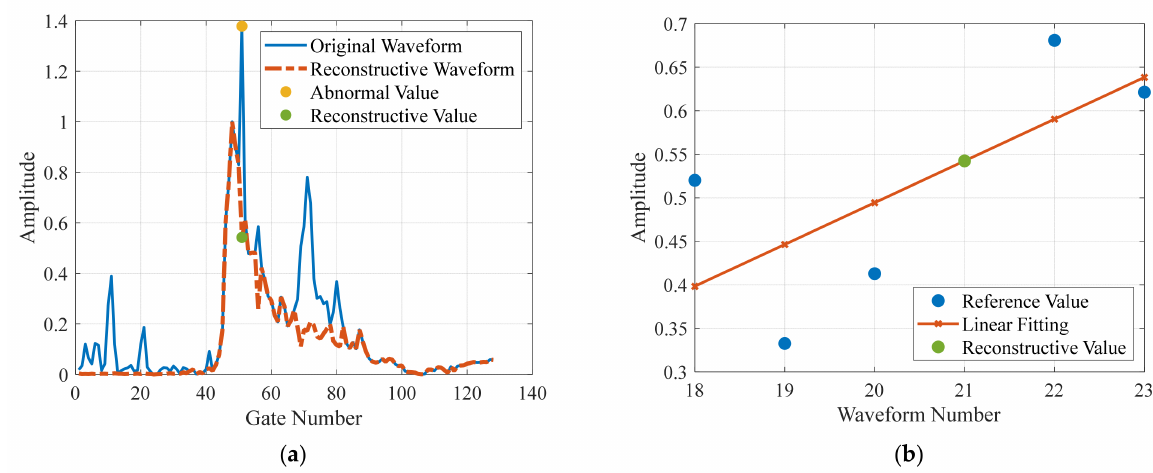
Figure 7. ( a ) The original contaminated coastal waveform (blue curve) and the corresponding reconstructive result (red dotted line). ( b ) The reference values (blue dots) used for linear fitting (red line) and the corresponding reconstructive value (green